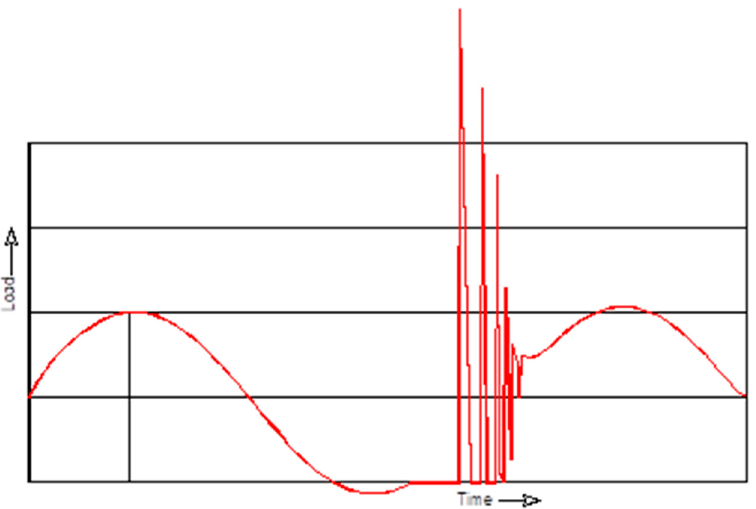
Figure 9. Slack towline followed by a large peak load ( ≈ 2.5 × Amplitude) [17]. Drawing: